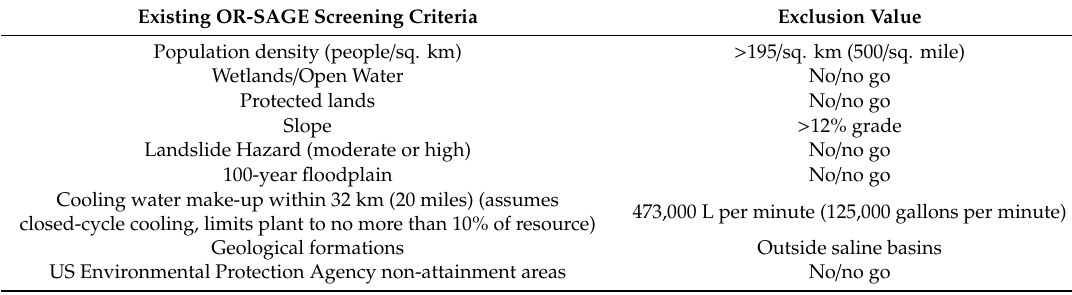
Table 3. Criteria used for selection in the geographic information system analysis.